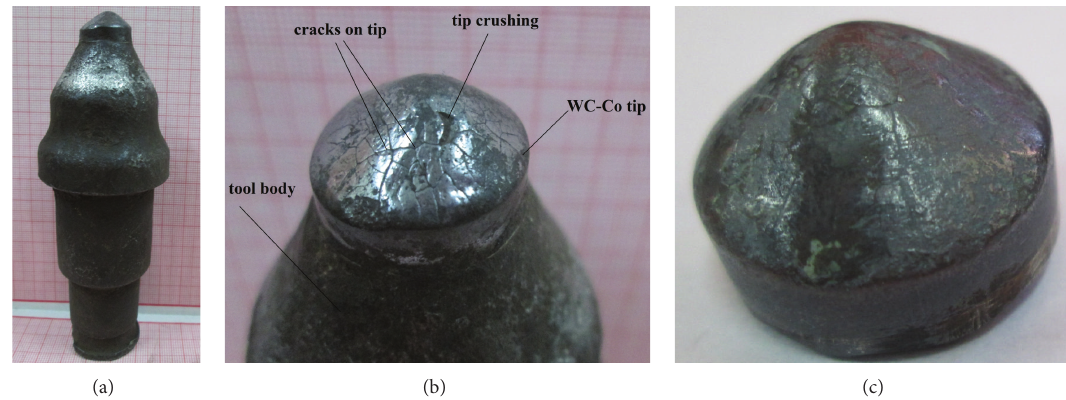
Figure 2: (a) Worn-out conical pick; (b) crushing and cracking of WC-Co tip; (c) sample to be tested on SEM.